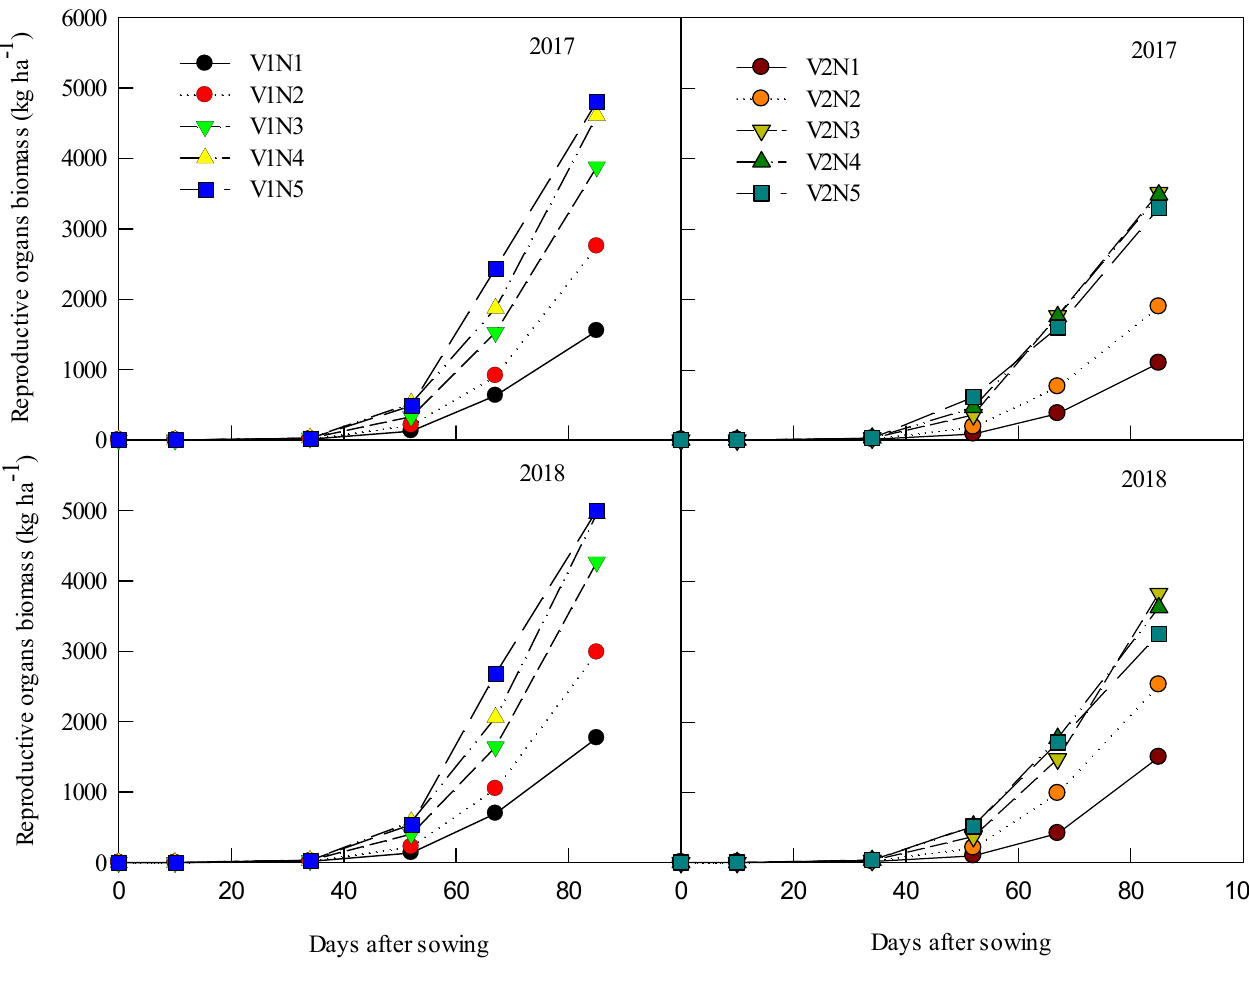
Figure 3. Changes in reproductive organ biomass yield in response to nitrogen fertilization and variety in 2017 and 2018. (n = 3). V1 and V2, represent FM hybrid (Zhangzagu 8) and FM local Variety (Bagu 214), respectively, while N1, N2, N3, N4 and N5 represent nitrogen application rates at 15, 61.7, 108.4, 155.1 and 201.8 kg ha − 1 , respectively. Table 2. Average accumulation rate of vegetative organ biomass (kg ha − 1 ) under different variety and nitrogen fertilization rates in 2017–2018.